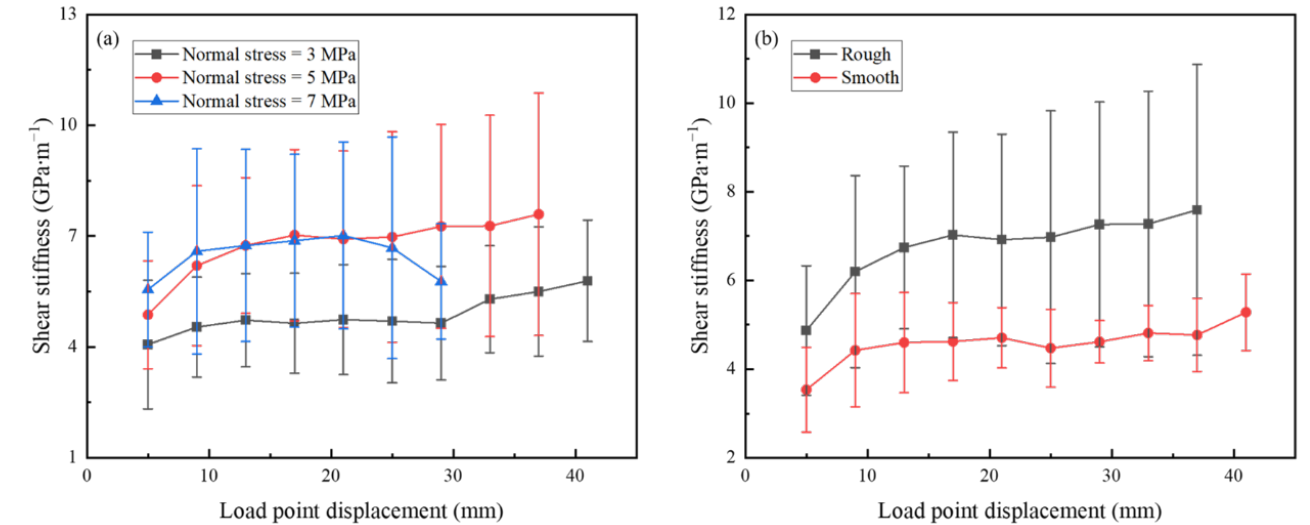
Figure 8. Test results with different slip displacements. The average value of the repeated test results is each data point, and the standard deviation is the length of error bar. ( a ) Trend of the average shear stiffness with the slip displacement under different normal stresses. ( b ) Trend of the average shear stiffness with the slip displacement under different roughness of the fault surfaces.